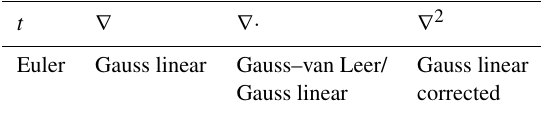
Table 1. Discretization schemes of the